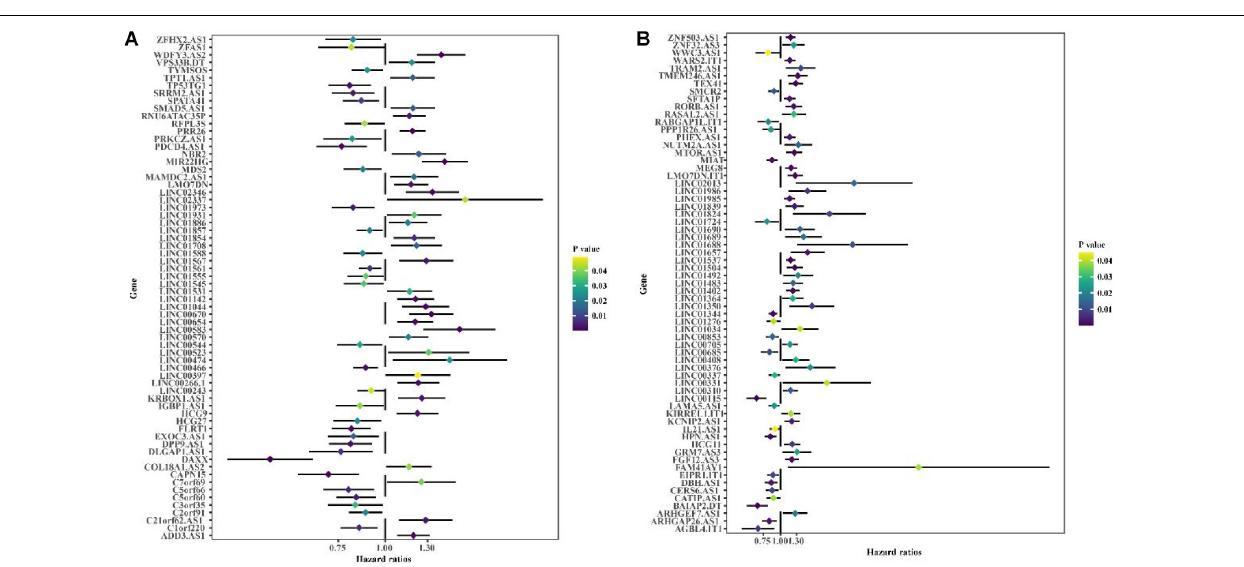
FIGURE 1 | GO and KEGG enrichment analysis of prognostic IRGs. (A) GO enrichment result. (B) KEGG enrichment result. The x -axis represented the ratio of the number of genes enriched in a single GO (or KEGG) term to the total number of genes changed in all GO (or KEGG) terms, and the y -axis represents GO (or KEGG) terms. The color of the circle indicated the adjusted p value, and the size represented the number of genes enriched in the term or the pathway.